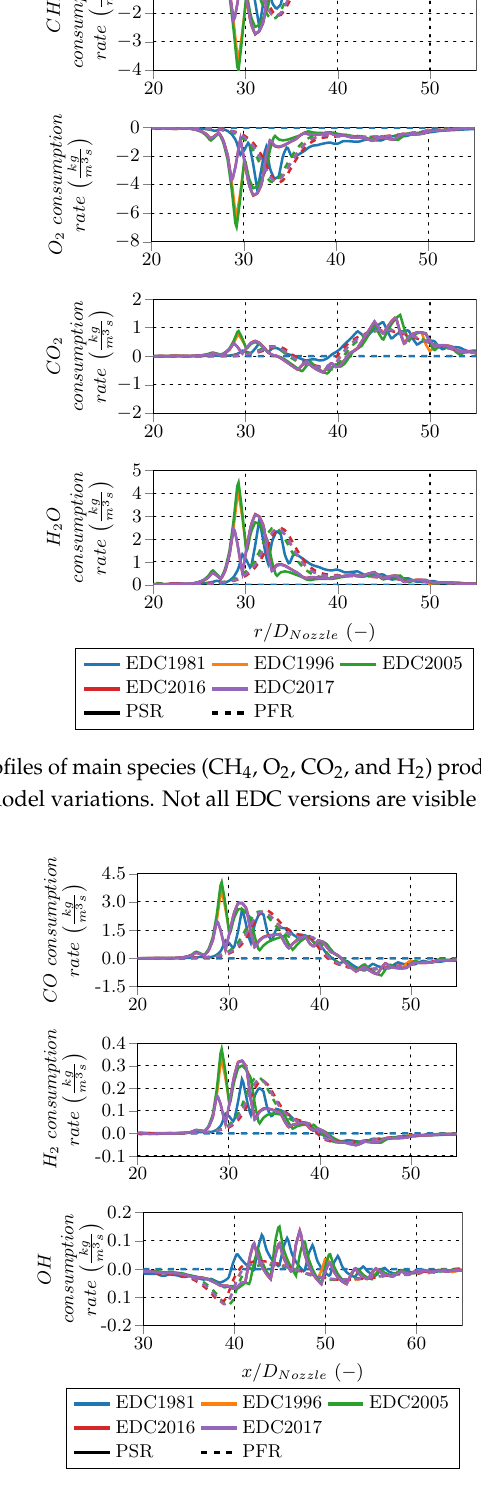
Figure 14. Centerline profiles of intermediate species (CO, H 2 , and OH) production or consumption rates of flame D for all EDC model variations.